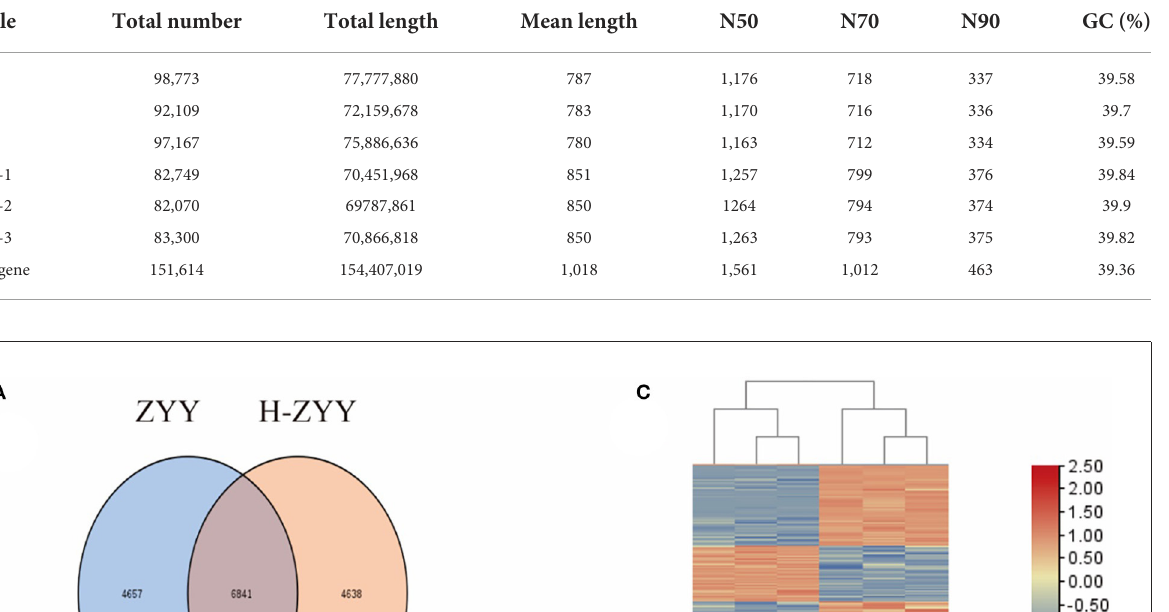
transcription factors and genes potentially involved in response to high-temperature treatment were extracted from the transcriptome database. Since the flower color of “Nannong Ziyunying” changed after high-temperature treatment, we